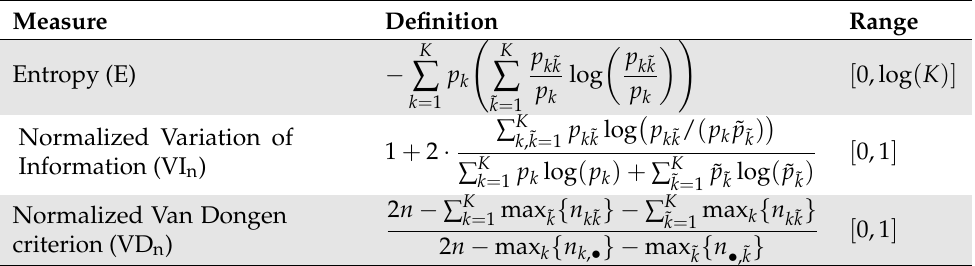
Table 2. Definitions of all considered clustering validation